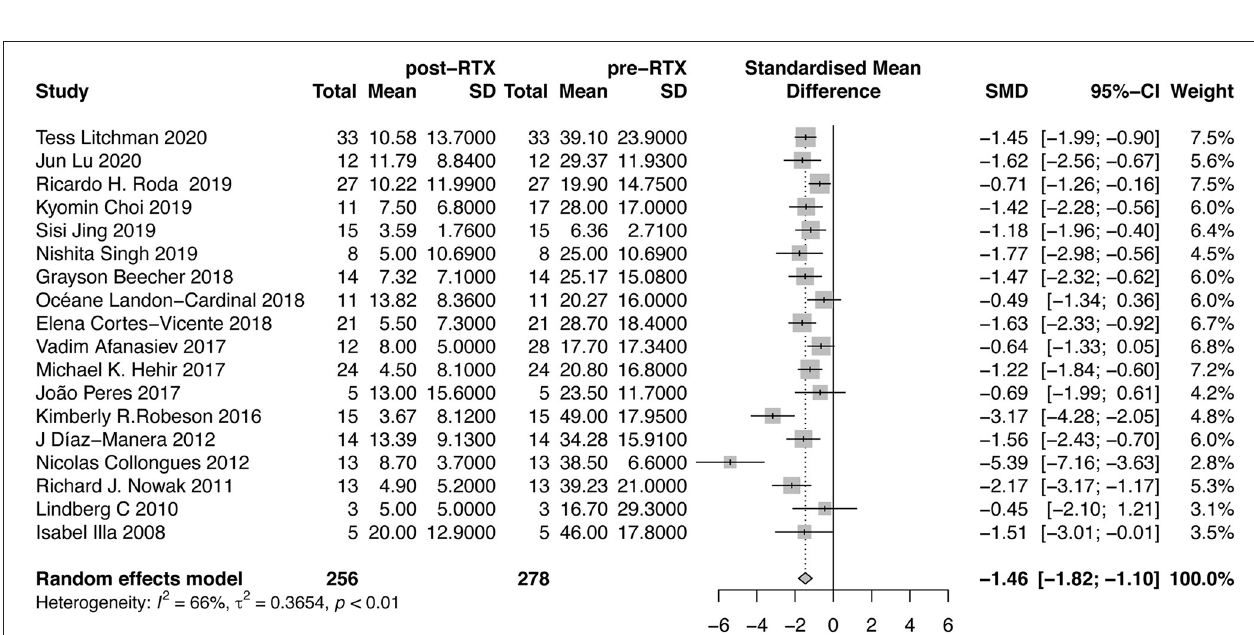
FIGURE 3 | Forest plot showing the mean effect size and 95% CI for the reduction of QMG score.